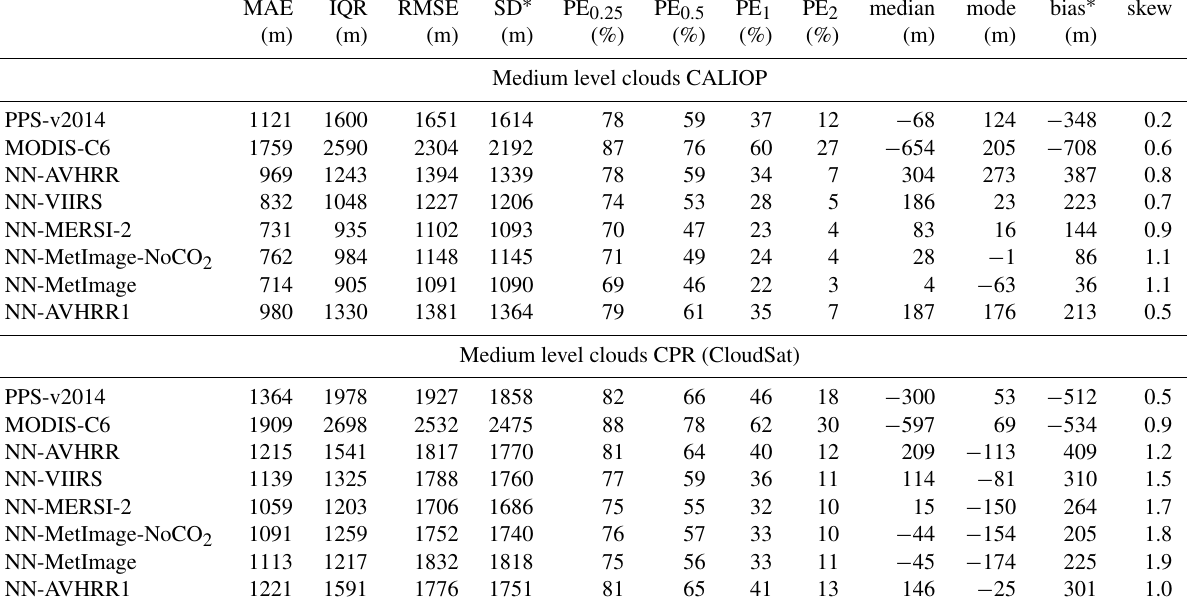
Table 8. Statistic measures for the error distributions for medium level clouds. For all measures except skewness it is the case that values closer to zero are better. The statistics are calculated for 244885 matches for CPR (CloudSat) and 295186 matches for CALIOP. The high class comes from CALIOP feature classification flag (class 4 and 5) and for CPR (CloudSat) it is the pixels with heights between the NWP height at 440 and 680hPa. PE X describes percentage of absolute errors above X km, see Eq.